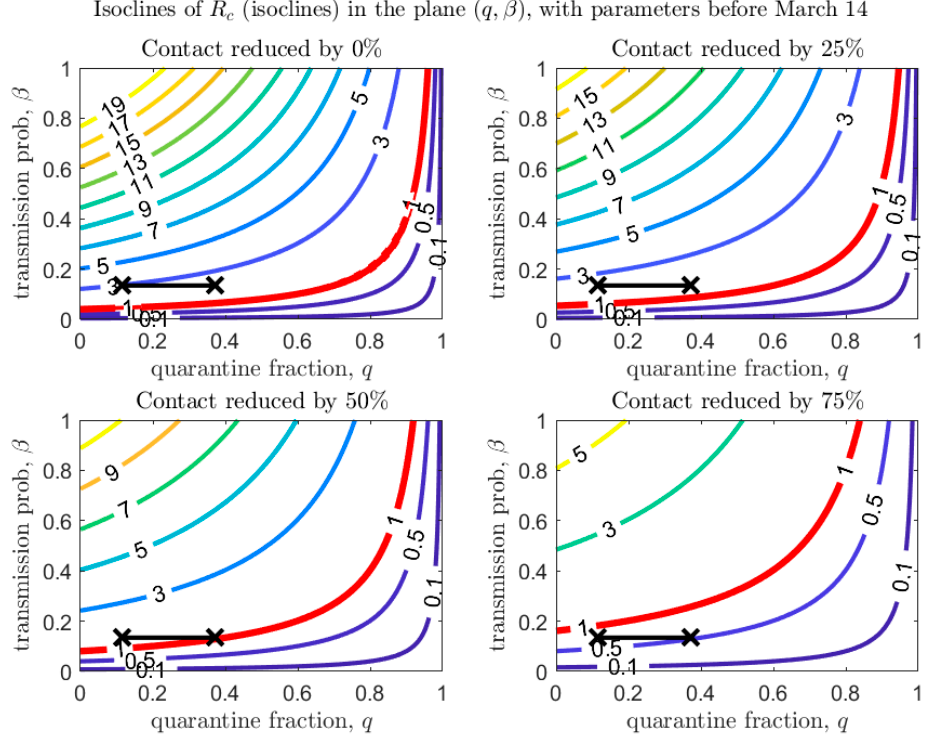
Figure 9. Same as Figure 7, with baseline parameters estimated in the period before March 14.